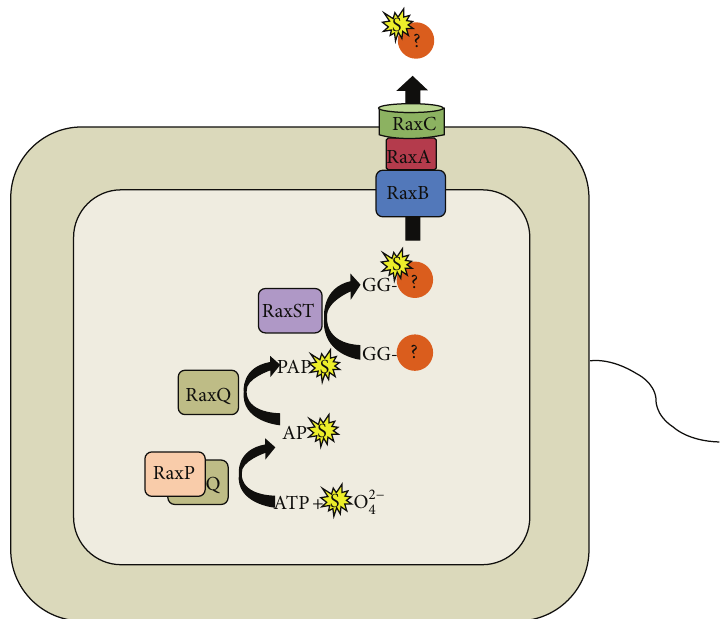
Figure 1: Working model for the synthesis and secretion of proteins required for activation of XA21-mediated immunity (encoded by rax genes). In this model, the adenosine-5 󸀠 -triphosphate (ATP) sulfurylase RaxP and the adenosine-5 󸀠 -phosphosulfate (APS) kinase RaxQ catalyze the production of the universal sulfuryl group donor 3 󸀠 -phosphoadenosine 5 󸀠 -phosphosulfate (PAPS). The RaxST sulfotransferase utilizes PAPS as a substrate. We hypothesize that RaxST sulfates a molecule that contains a leader peptide, which is cleaved by the peptidase domain of the RaxB protein and secreted outside the bacterial cell by the RaxABC